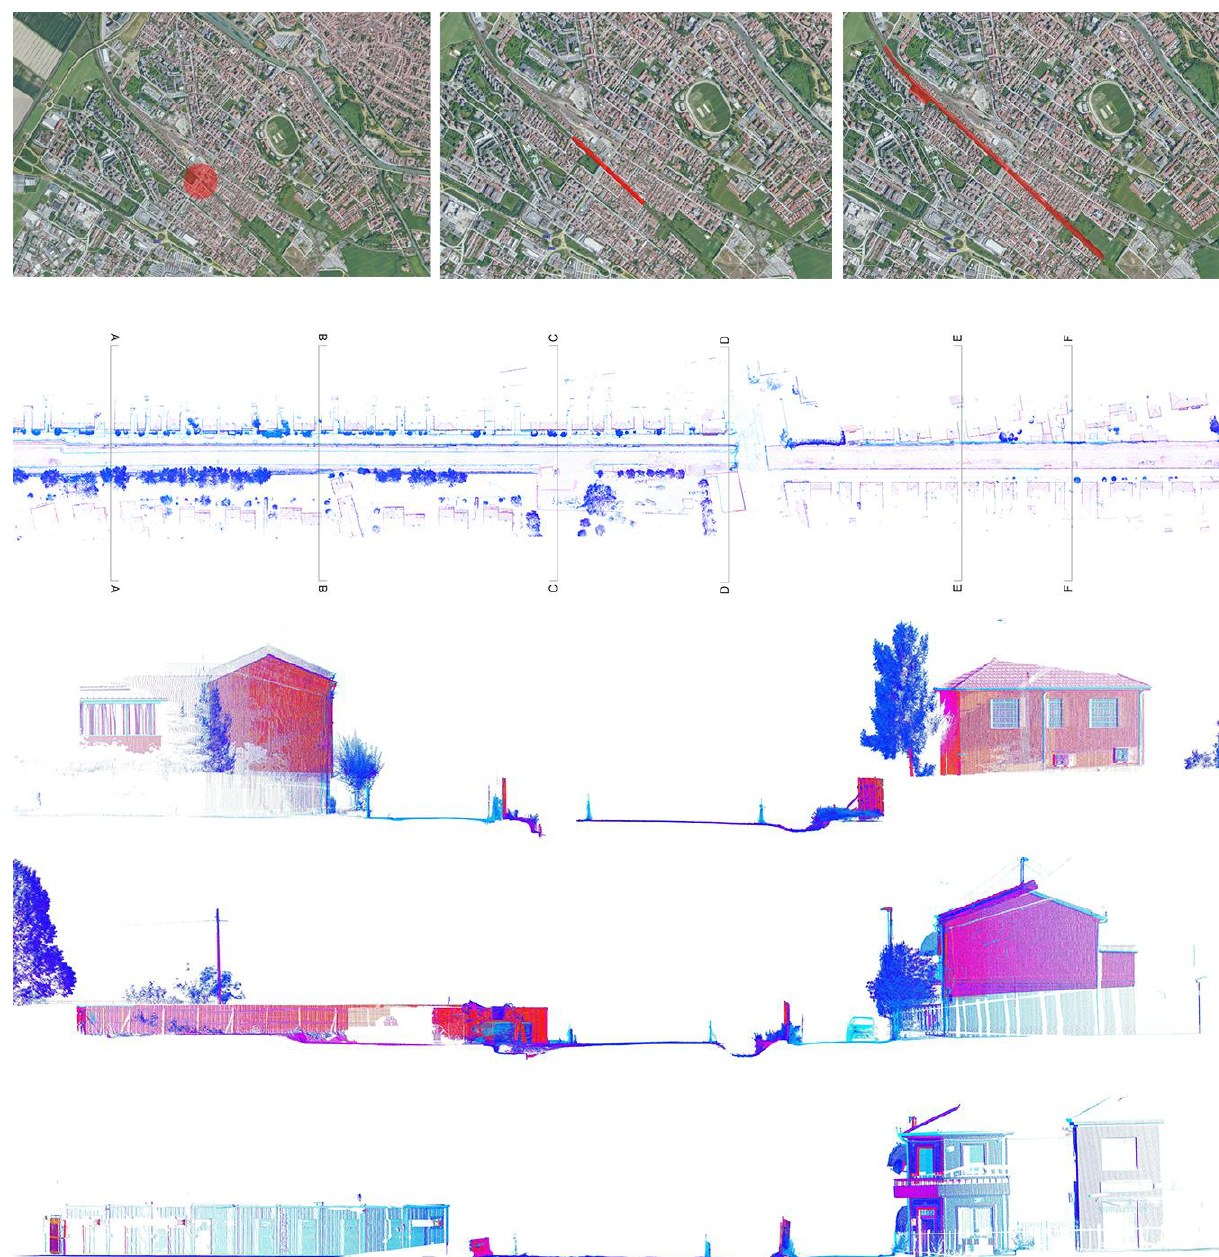
Figure 4. The information density and accuracy of the 3D database make it possible to query information from the urban scale to the scale of architectural